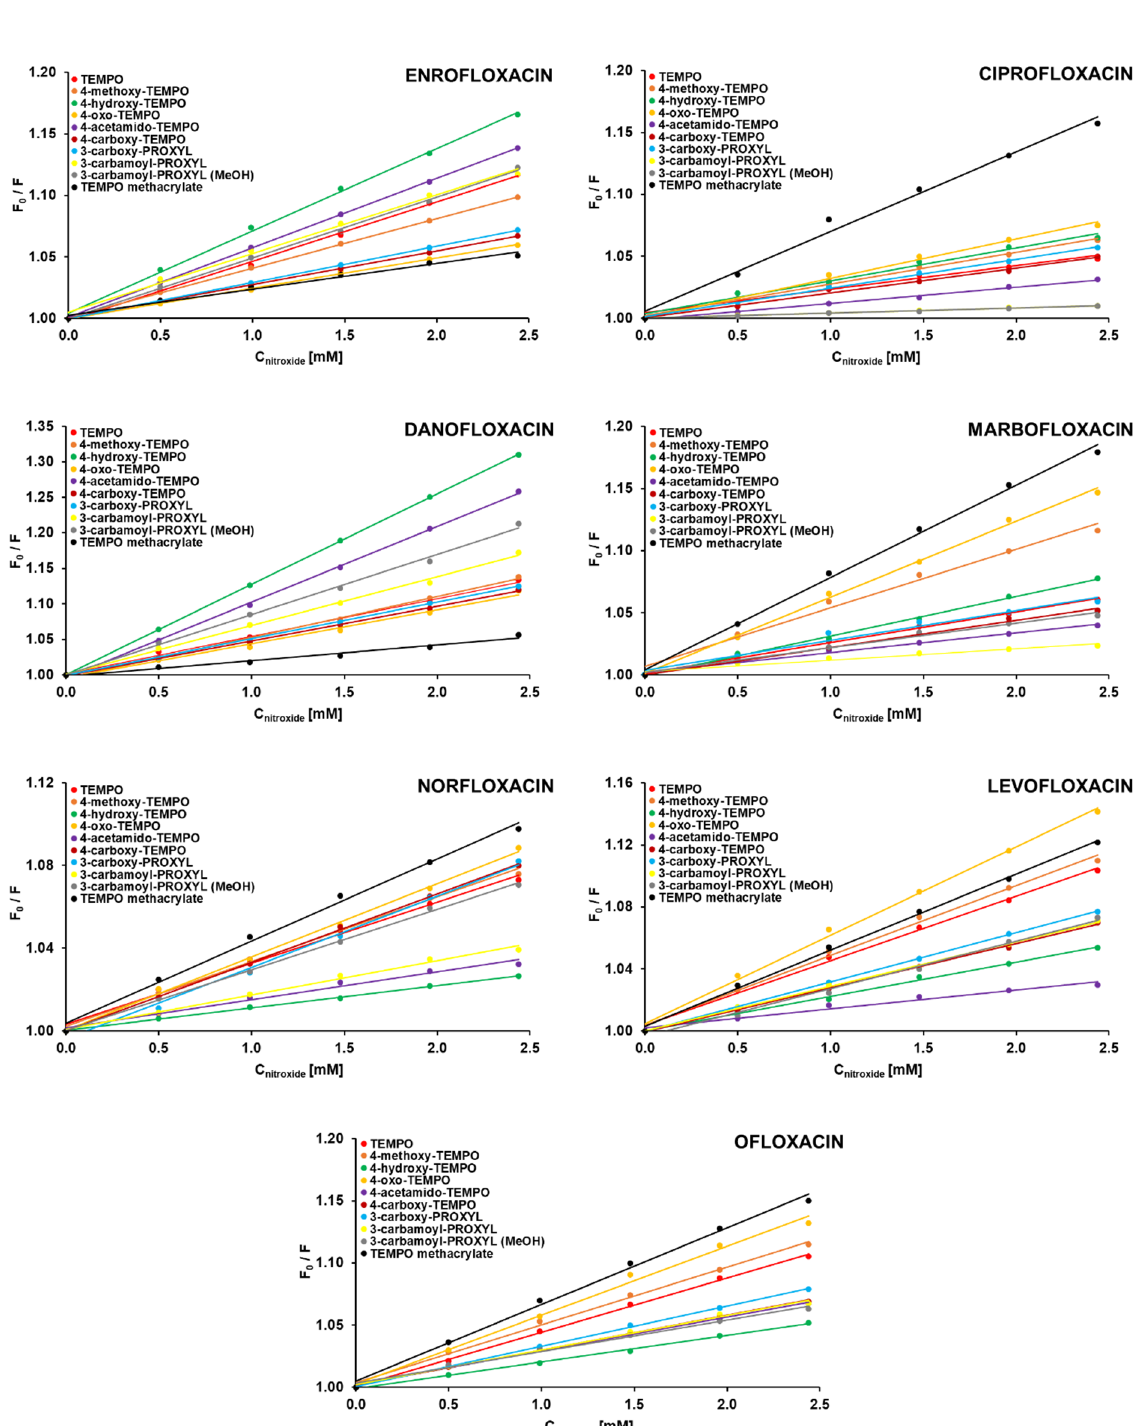
Figure 1. Stern–Volmer plots for the steady-state fluorescence quenching of the studied fluoroquinolones by different 2,2,6,6- tetramethylpiperidinyl- N -oxyl (TEMPO) and 2,2,5,5-tetramethylpyrrolidynyl- N -oxyl (PROXYL) derivatives in aqueous solutions at 20 ◦ C. F 0 and F are the fluorescence intensities of the fluoroquinolones in the absence and presence of the nitroxides, respectively. The results are shown as a mean of three independent experiments. In all experiments, standard deviations were less than 4%, and thus, for better clarity, error bars were